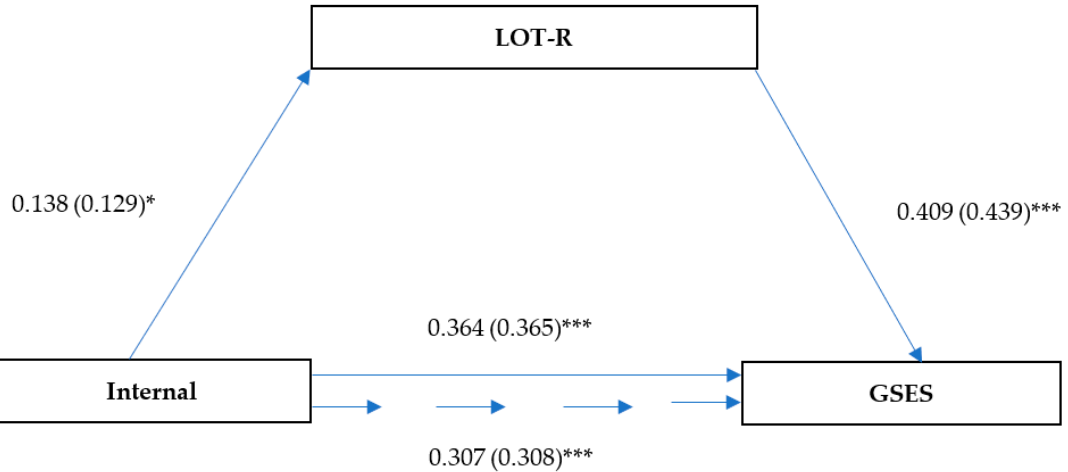
Figure 3. Model of relationships between health locus of control (internal control), dispositional optimism, and self-efficacy. Unstandardized coefficient (standardized coefficient) * p < 0.05; *** p < 0.001.